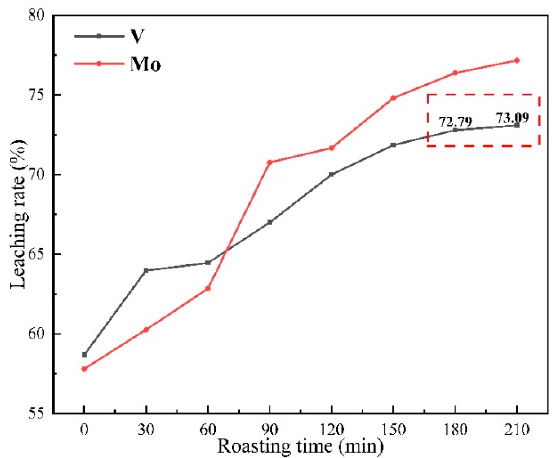
Figure 8. Effects of K 2 CO 3 carbonation time on the leaching rates of V and Mo.